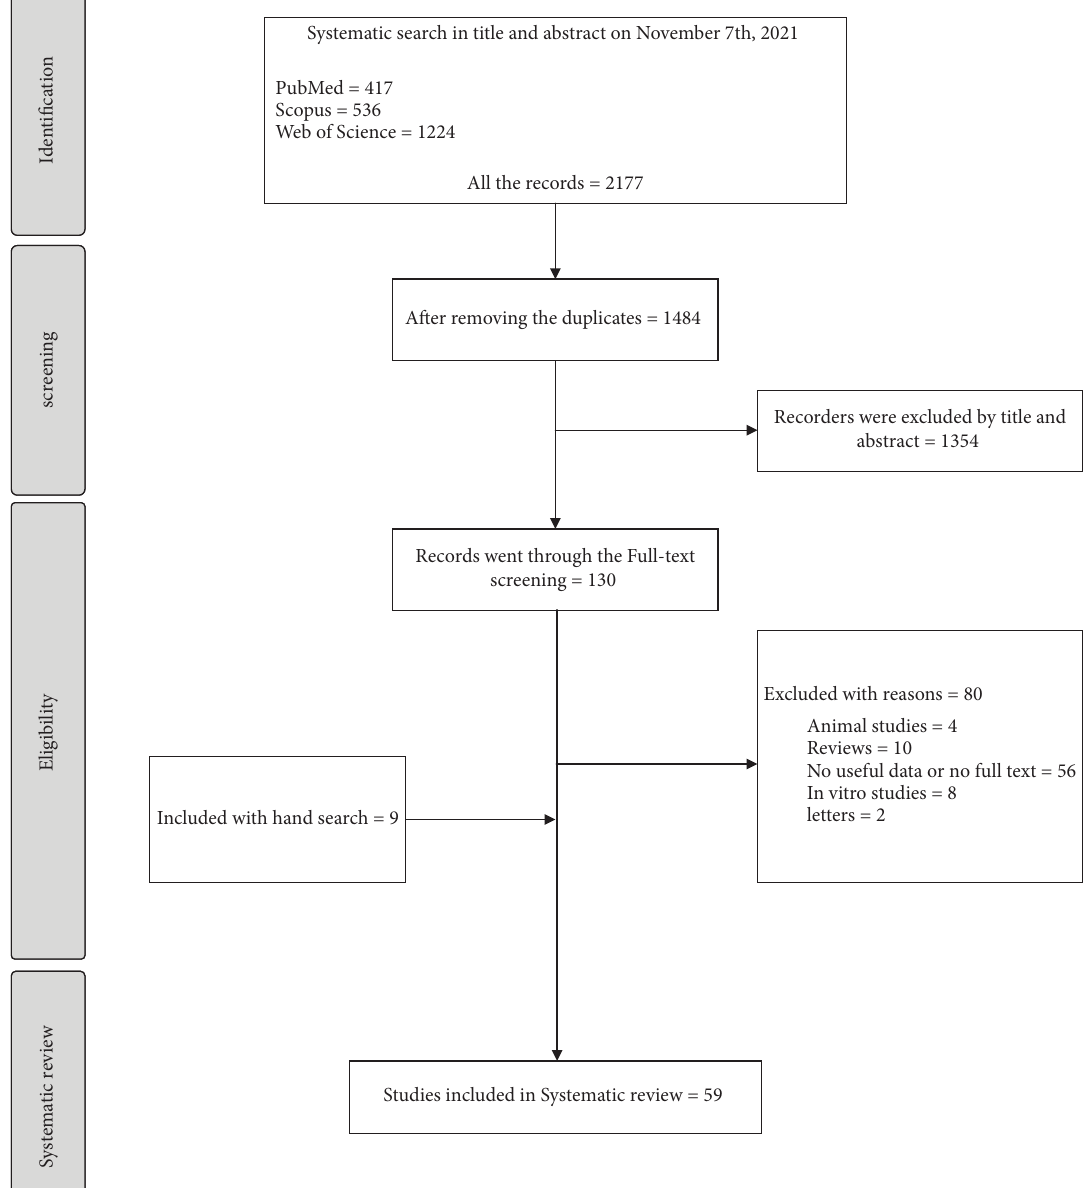
Figure 1: Te PRISMA fow diagram of study